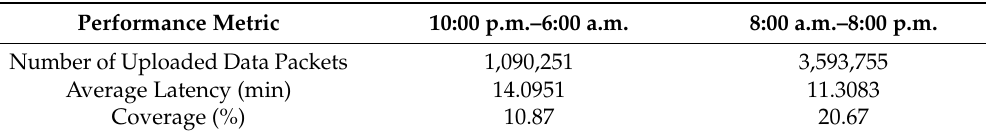
Table 5. Experimental results at different time in one day.